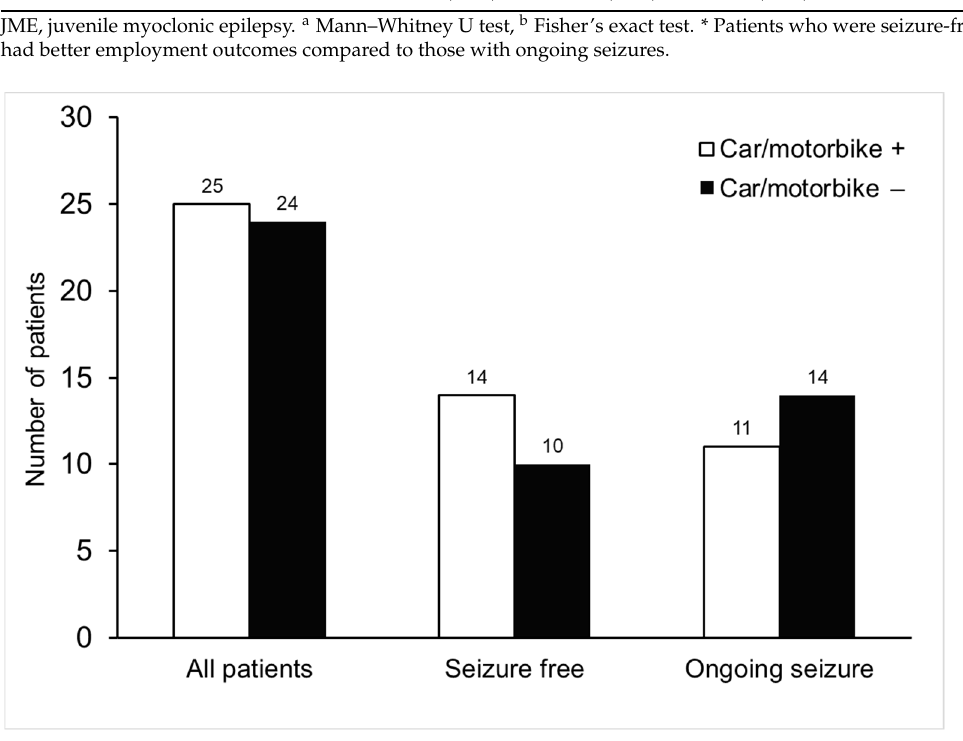
Figure 1. The frequency of vehicle operation among patients who were seizure-free and those with ongoing seizures. The numbers of patients who drove cars or motorbikes and those who did not operate any vehicles are presented for each subgroup. No statistically signi fi cant di ff erences were observed between the groups of vehicle operators and non-operators in both seizure-free and ongo- ing seizure subgroups ( p =